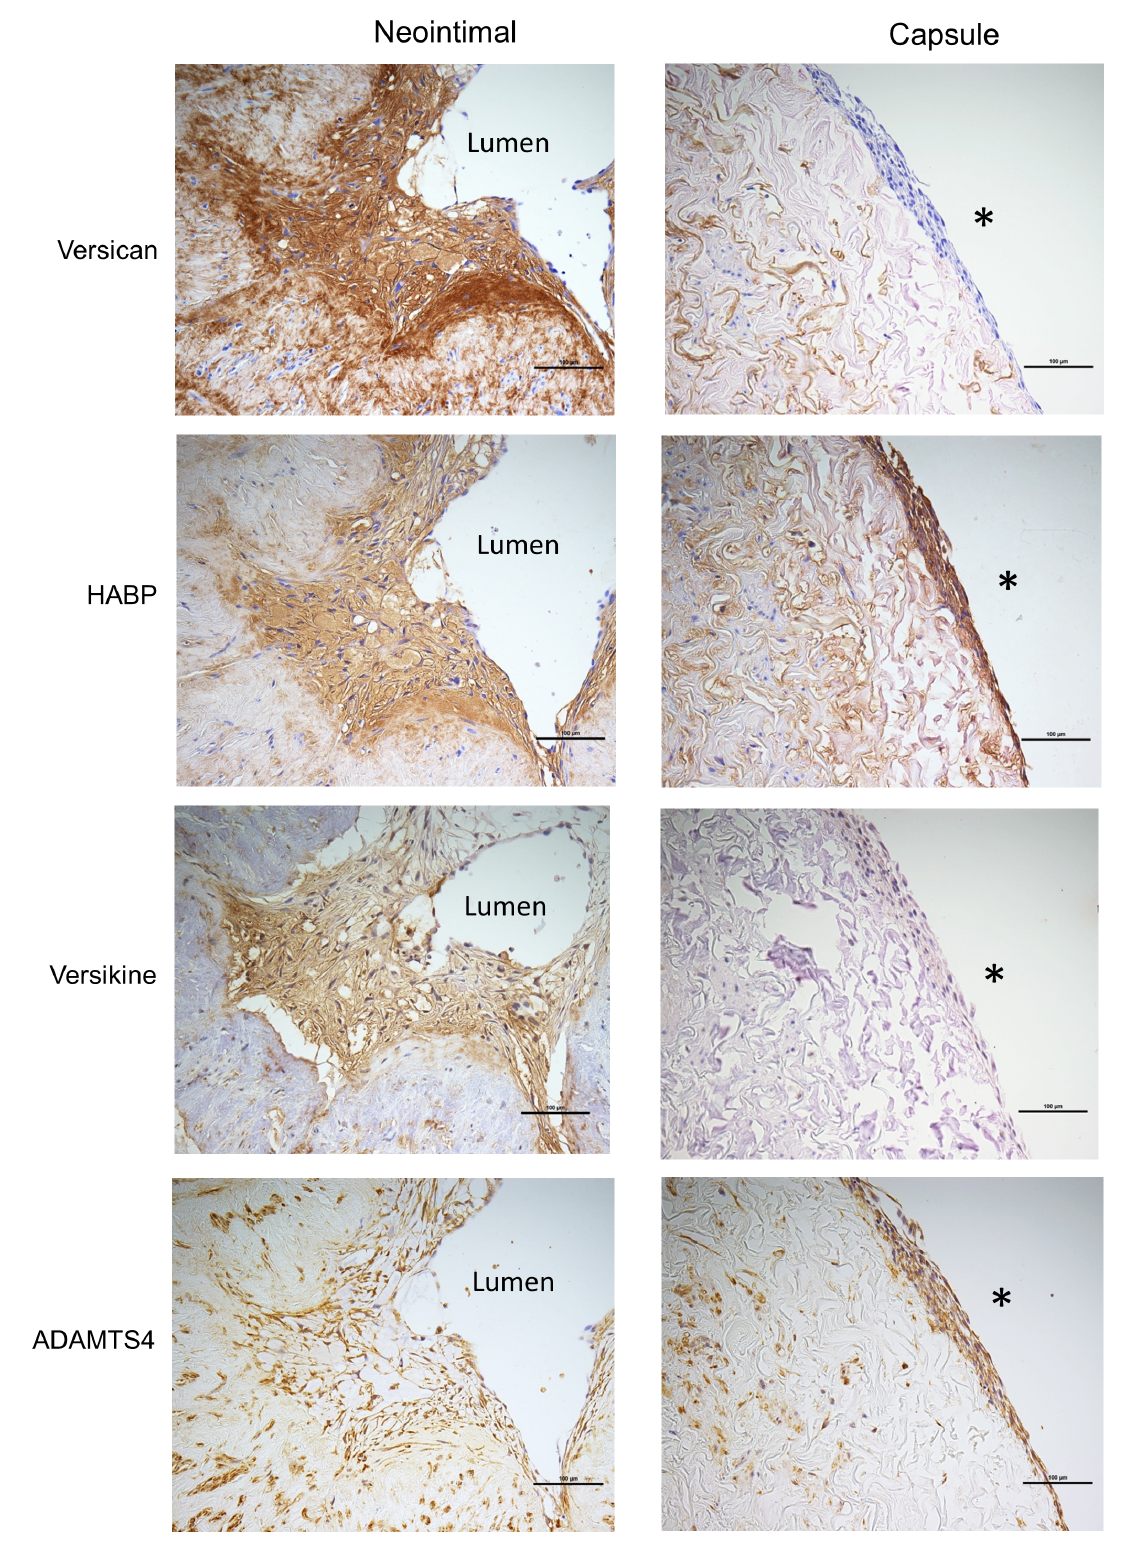
Fig 6. Immunostaining of cells in the neointima and adventitial capsule. Histochemical and immunostaining of neointimal cells and capsule cells (left and right panel, respectively) for (A) versican, (B) hyaluronan, (C) versikine, and (D) ADAMTS4. (cid:3) indicates the adventitial surface. Scale bars indicate 100